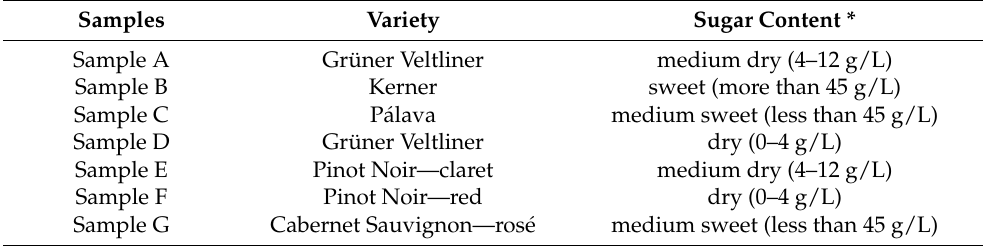
Table 1. Samples’ description, harvest 2015.